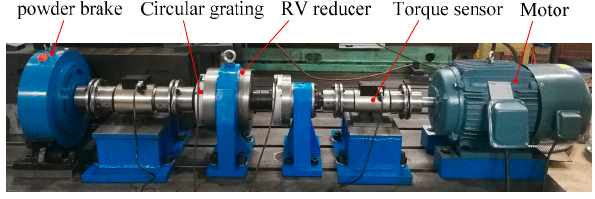
Figure 14. RV reducer tester.